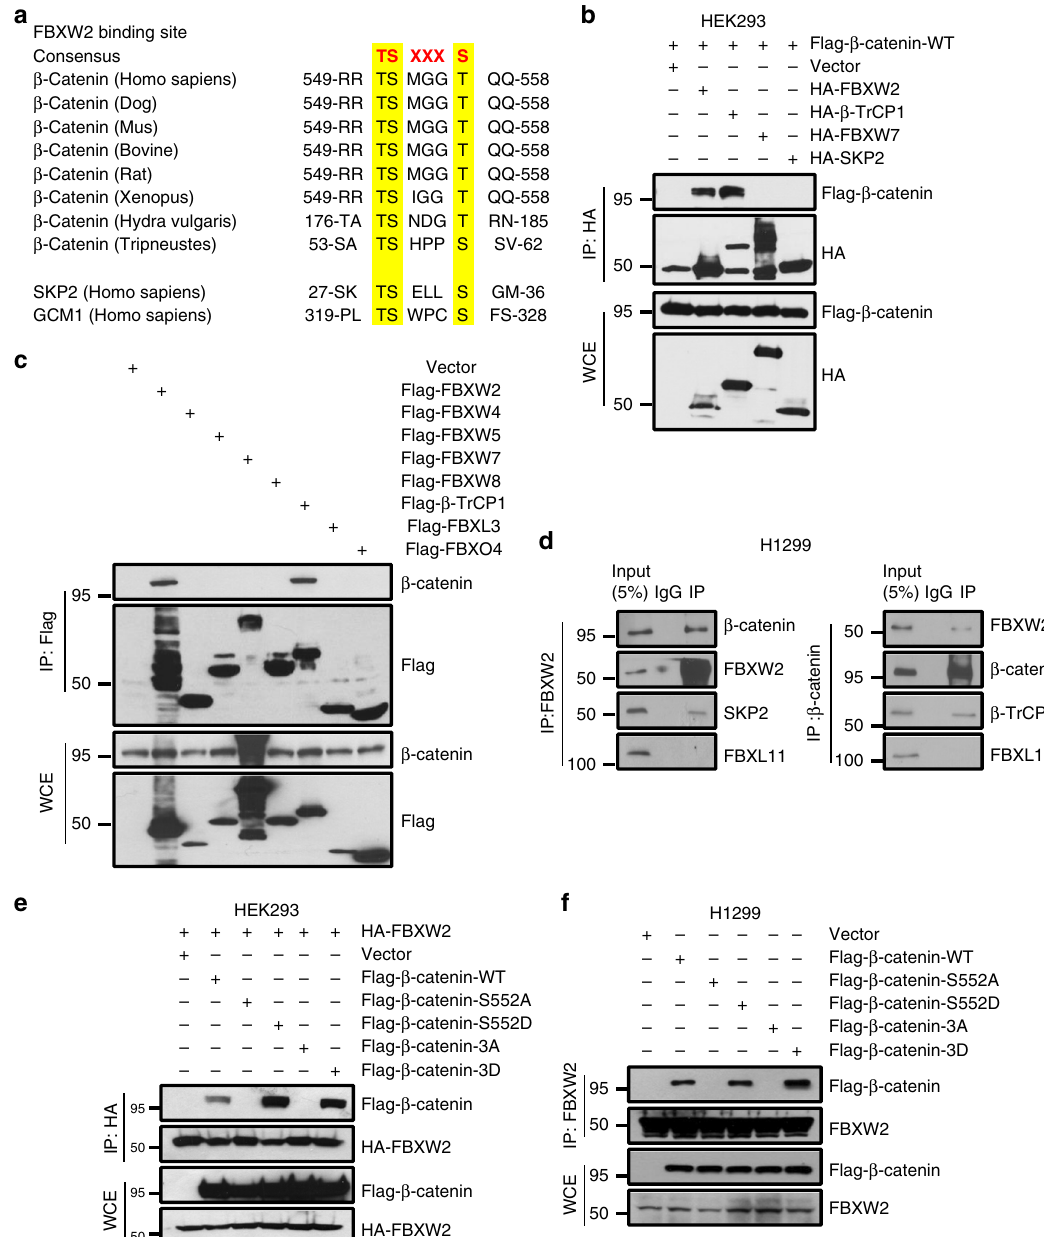
Fig. 1 FBXW2 binds to β -catenin via its consensus degron motif. a Evolutionary conservation of FBXW2 degron motif on β -catenin. b , c FBXW2 binds to exogenously expressed ( b ) or endogenous β -catenin ( c ): HEK293 cells were transfected with indicated plasmids, followed by IP with anti-HA ( b ) or Flag Ab ( c ) and IB with indicated Abs. WCE: whole-cell extract. d FBXW2 binds to endogenous β -catenin: Cell lysates from H1299 cells were pulled down with anti-FBXW2 or anti- β -catenin Abs, followed by IB with indicated Abs. e The interaction between FBXW2 and β -catenin is dependent on the three S/T residues on the degron motif: β -catenin or its S → A or S → D mutants on FBXW2 degron motif was co-transfected with HA-FBXW2, followed by IP with HA Ab and IB with indicated Abs. f Endogenous FBXW2 binds to wild type β -catenin or its constitutively active mutants, but not its inactive mutants on the degron motif: H1299 cells were transfected with indicated plasmids, followed by IP with FBXW2 Ab and IB with indicated Abs. Unprocessed original scans of blots are shown in Supplementary Figure